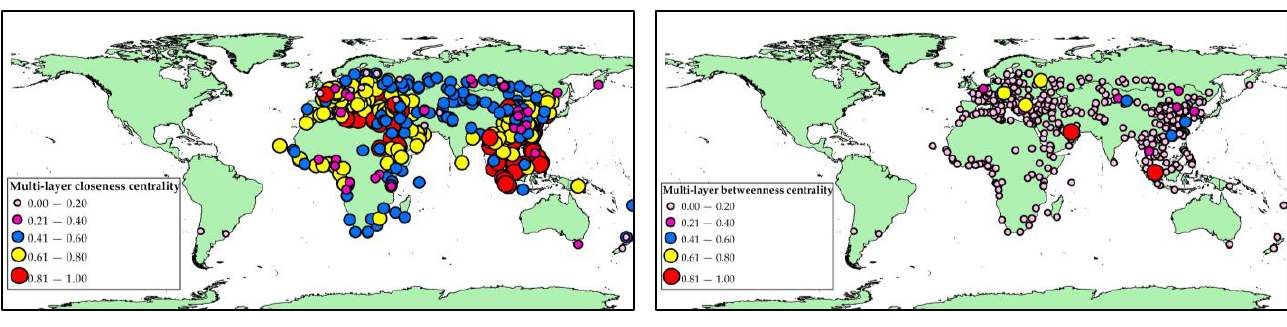
( d ) Geographical distribution of multi-layer between- ness centrality. Figure 5. Geographical distribution of different multi-layer centrality of node cities.